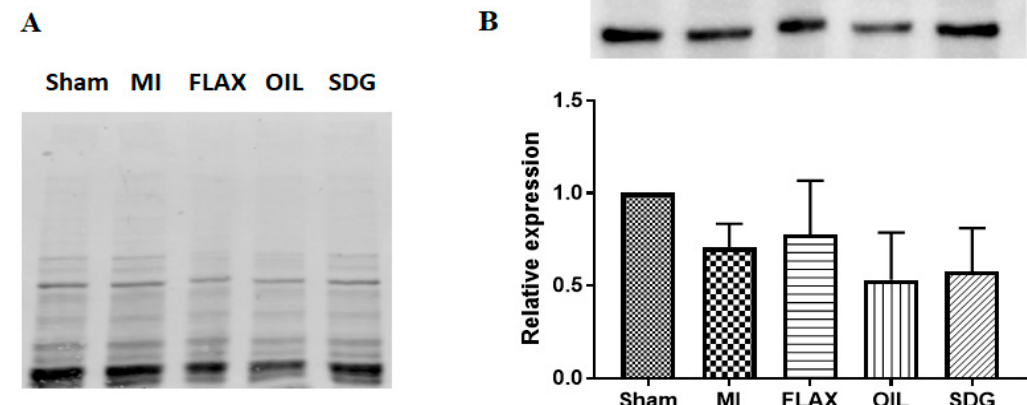
Figure 5. Effect of the dietary interventions on NCX levels. ( A ) TGX gel visualization by Bio-Rad Gel Doc TM XR+ imager to confirm equal protein loading. ( B ) Densitometric quantification of the immunoblots, data are presented as mean ± SD, n = 5. ALA, alpha-linolenic acid; FLAX, chow diet supplemented with 10% ground flaxseed; MI, myocardial infarction; OIL, chow diet supplemented with 4.4% ALA enriched flax oil; SDG, chow diet supplemented with 0.44% secoisolariciresinol diglucoside.